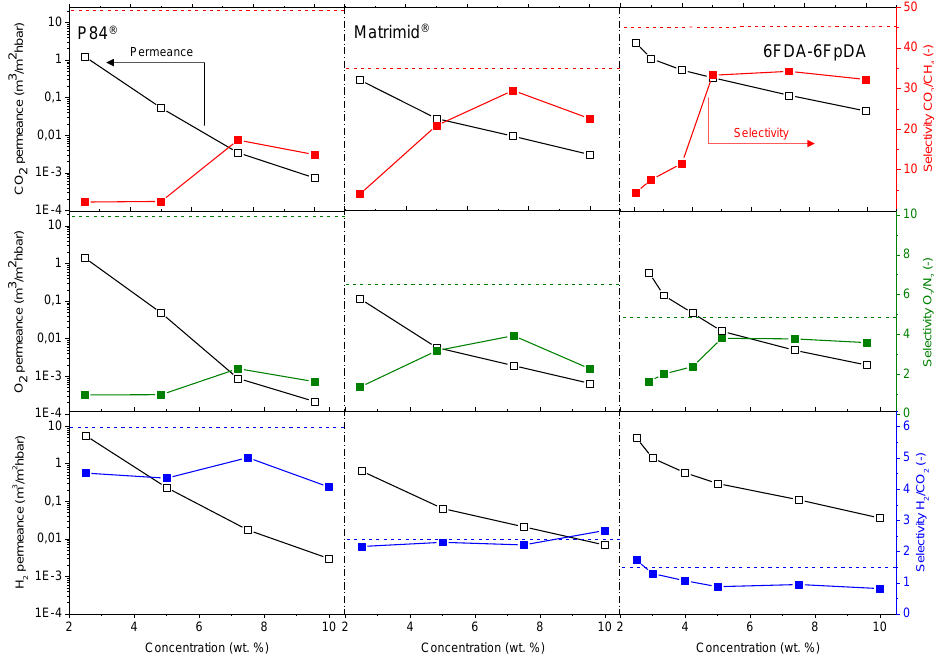
Figure 7. Separation properties of the polymers as a function of the solution concentration at 30 °C. Dashed lines refer to the ideal selectivity for each polymer and gas pair. Permeance values (left-y axis) are plotted in logarithmic scale.